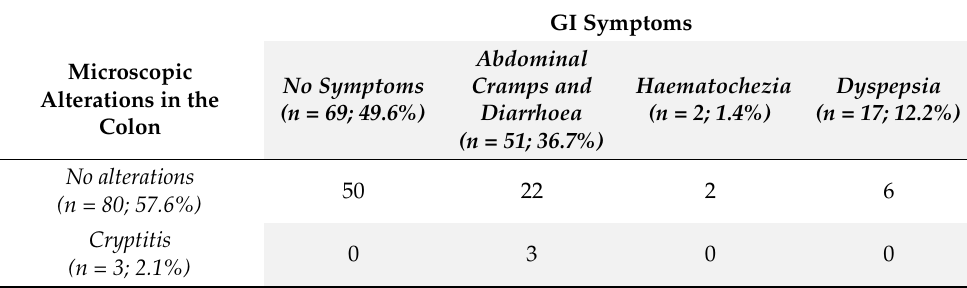
Table 5. Correlation between GI symptoms and microscopic alterations in the